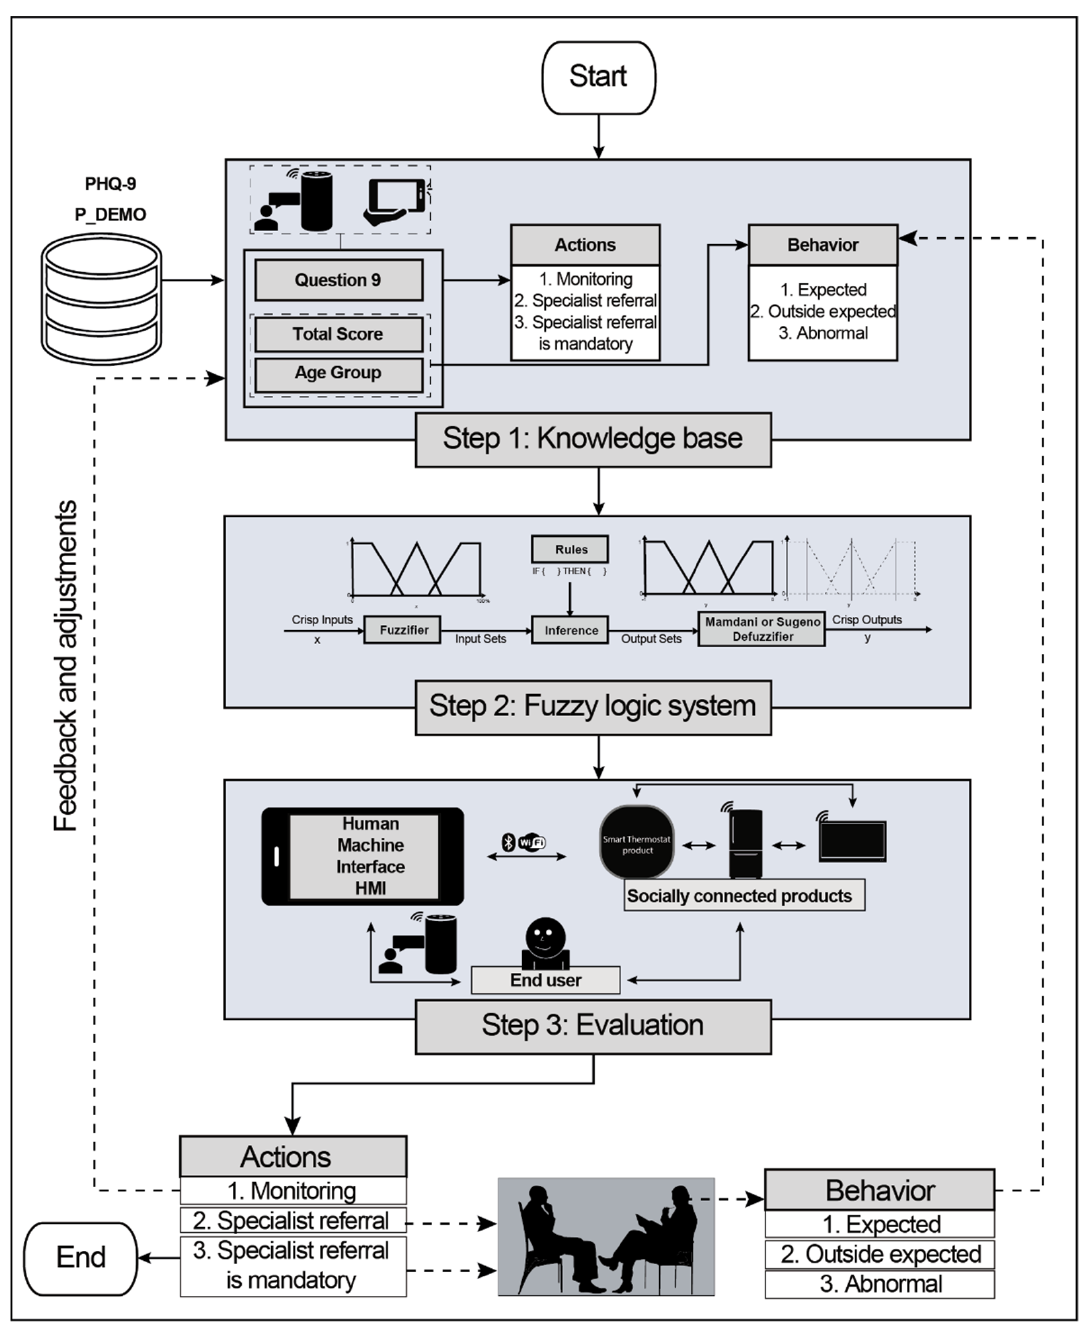
Figure 4. Proposed Framework.